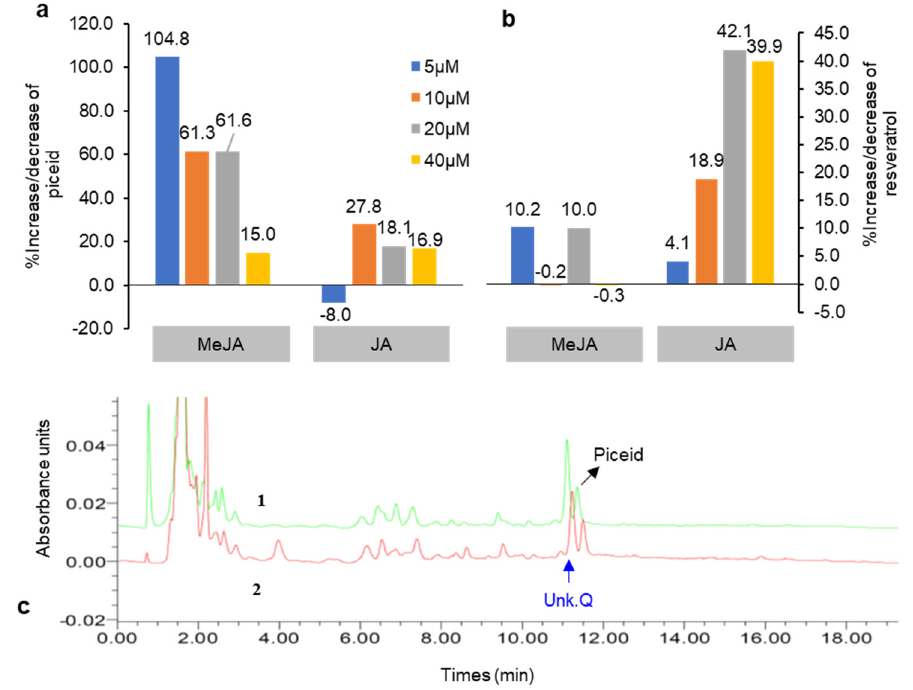
Figure 4. Percentage increase and decrease in piceid ( a ) and resveratrol content ( b ) in DJ526 cell suspension after treatment with jasmonic acid (JA) and methyl jasmonate (MeJA) under 5-day elicitation periods (compared with the untreated control). ( c ) Chromatogram representing an increase in piceid and unknown compound Q content in the 5 day MeJA (5 μ M)-treated cell suspension ( 1 ) relative to the control ( 2 ).